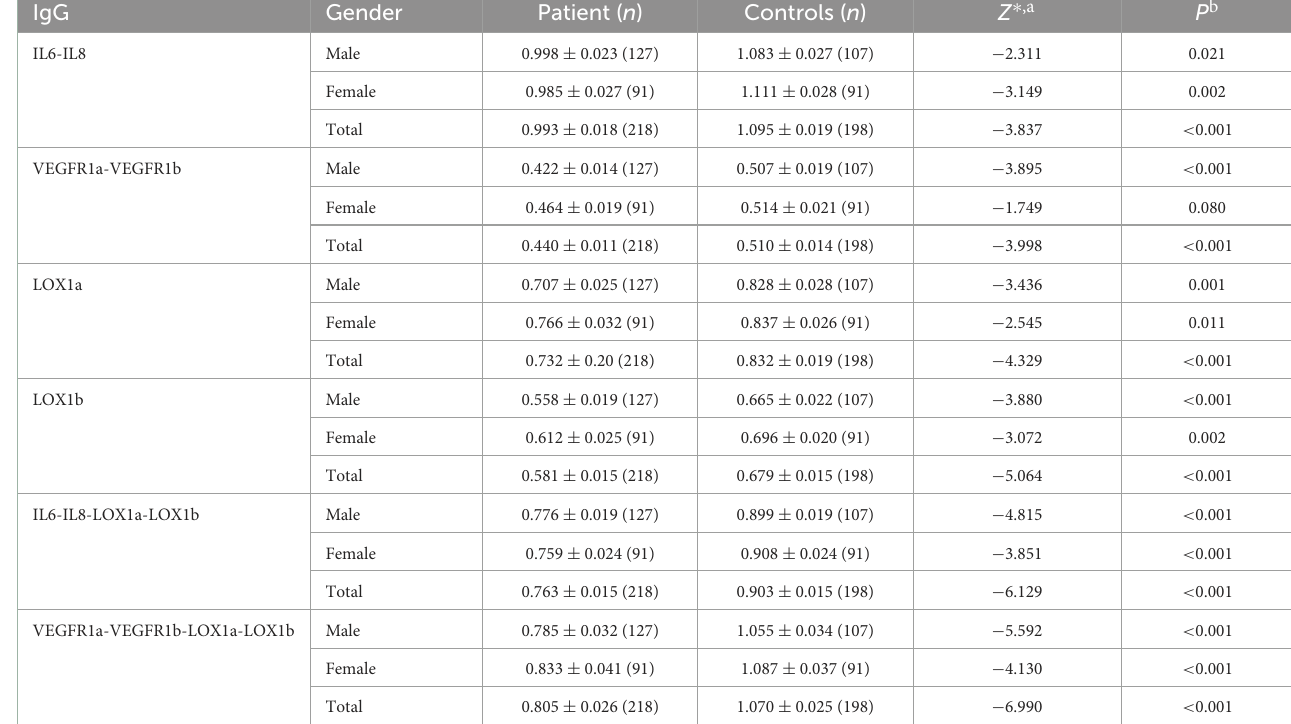
TABLE 4 Plasma levels of IgG NAbs against peptide antigens derived from specific target molecules in patients with ischemic stroke and control subjects.